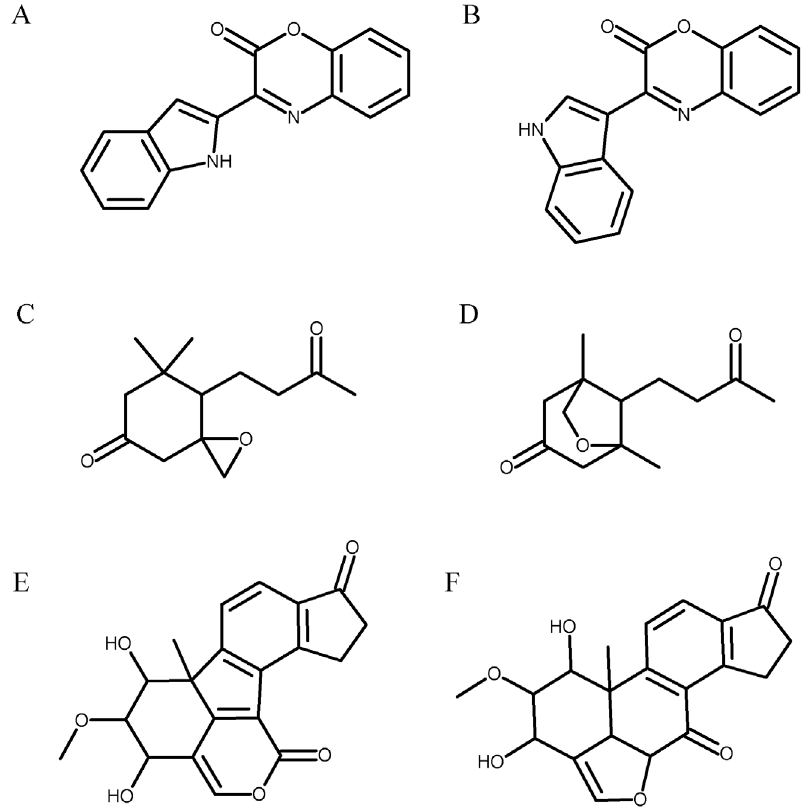
Figure 1. Structures of natural products challenging for NMR spectroscopy. A and B: Two of the candidate structures of Cephalandole A evaluated by Gross et al. B is the correct structure (6). The proposed (C) and revised structures (D) of TAEMC161 [7,8]. The proposed (E) and revised structures (F) of Annuionone A [9,10].